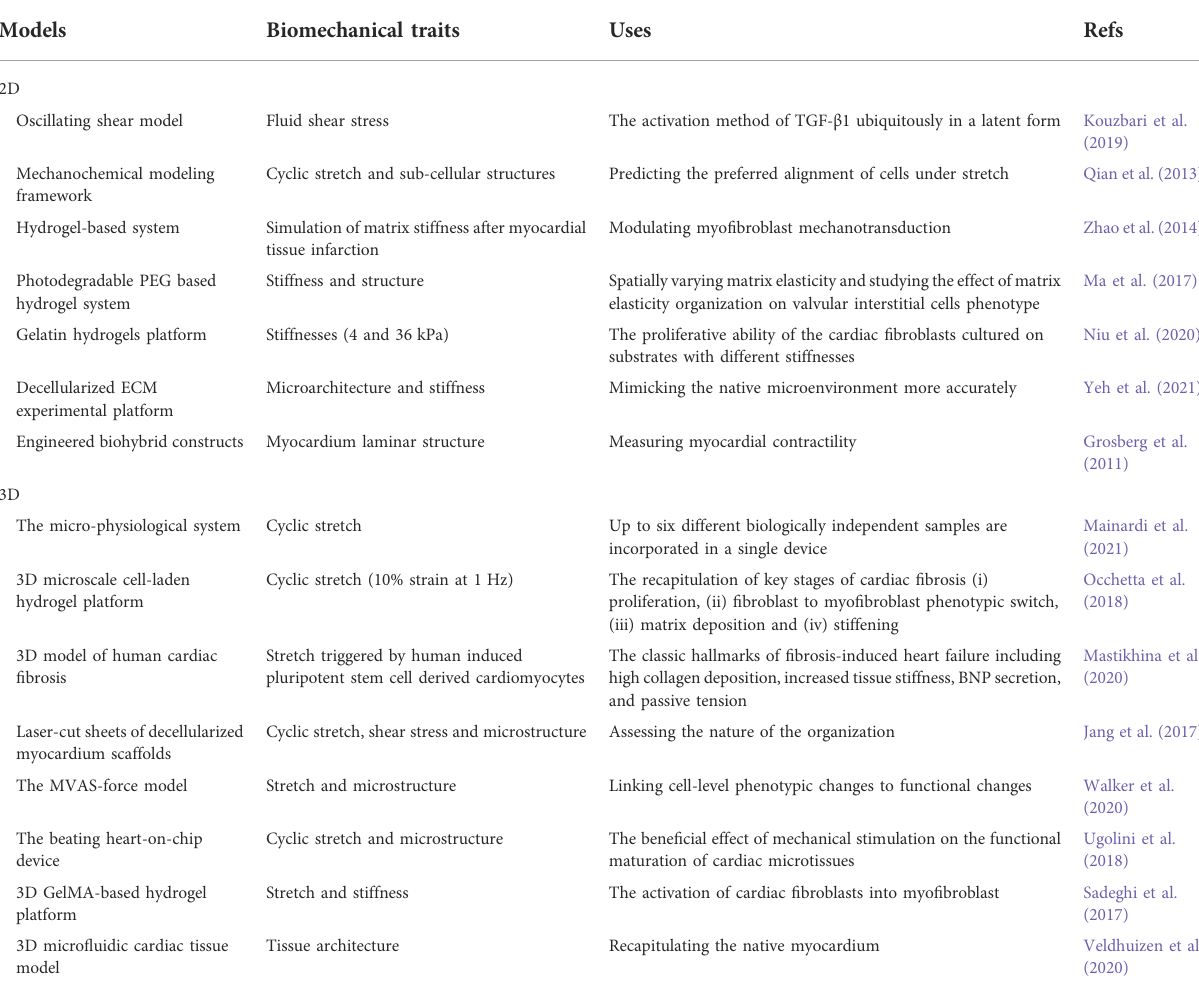
TABLE 1 Examples of modeling biomechanical traits in 2D or 3D cell culture.